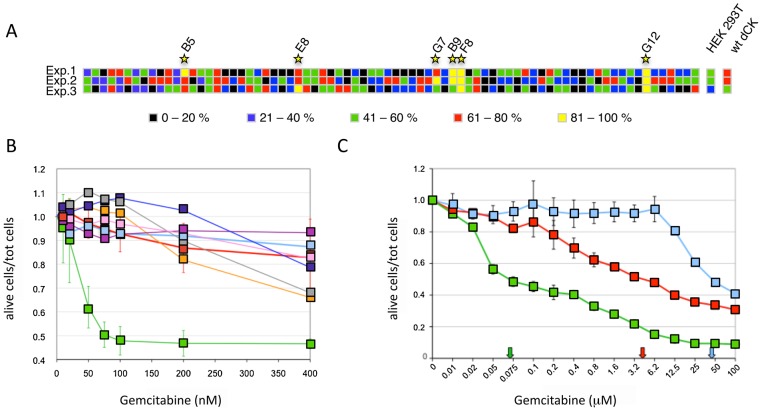
Screening of the dCK library.
Panel A. Viability of 76 isolated clones of HEK-293T transduced with the dCK-F16 viral library at a MOI<1 in the presence of 10 nM Gemcitabine. The different colors represent the percentage of dead cells on the total of seeded cells. Each line corresponds to an independent experiment, and each column to one clone. The results obtained with untransduced cells and cells transduced with the wt-dCK gene are given on the right (“HEK-293T” and “wt-dCK”, columns, respectively). Panel B. Viability of selected Messa10K “polyclonal populations” in the presence of increasing concentrations of Gemcitabine. Thick pale blue line, untransduced Messa10K cells; thick red line, cells transduced with wt-dCK; thin lines, cells transduced with the vectors derived from the clones identified in HEK-293T (Figure 1D): pink, B9; gray, B5; dark blue, F8; purple, G7; orange, E8; green, G12. Values represent the ratio of the number of live cells over the total of cells seeded for each Gemcitabine concentration. For each dCK variant, 4 to 9 populations of Messa10K cells were generated independently, as described in Figure S1, and for each population the experiment was carried out in duplicate. For the sake of clarity, the error bars are shown only for samples G12 and wt-dCK. The values of G12 and wt-dCK are significantly different for every Gemcitabine concentration tested (p<0.0001). Panel C. Cell death for Messa10K “polyclonal populations” either non-transduced (light blue) or transduced with the wt-dCK (red) or the G12 variant (green), with a larger range of Gemcitabine concentrations than in panel B. The arrows indicate the IC50 values for Gemcitabine in the three different cell types.